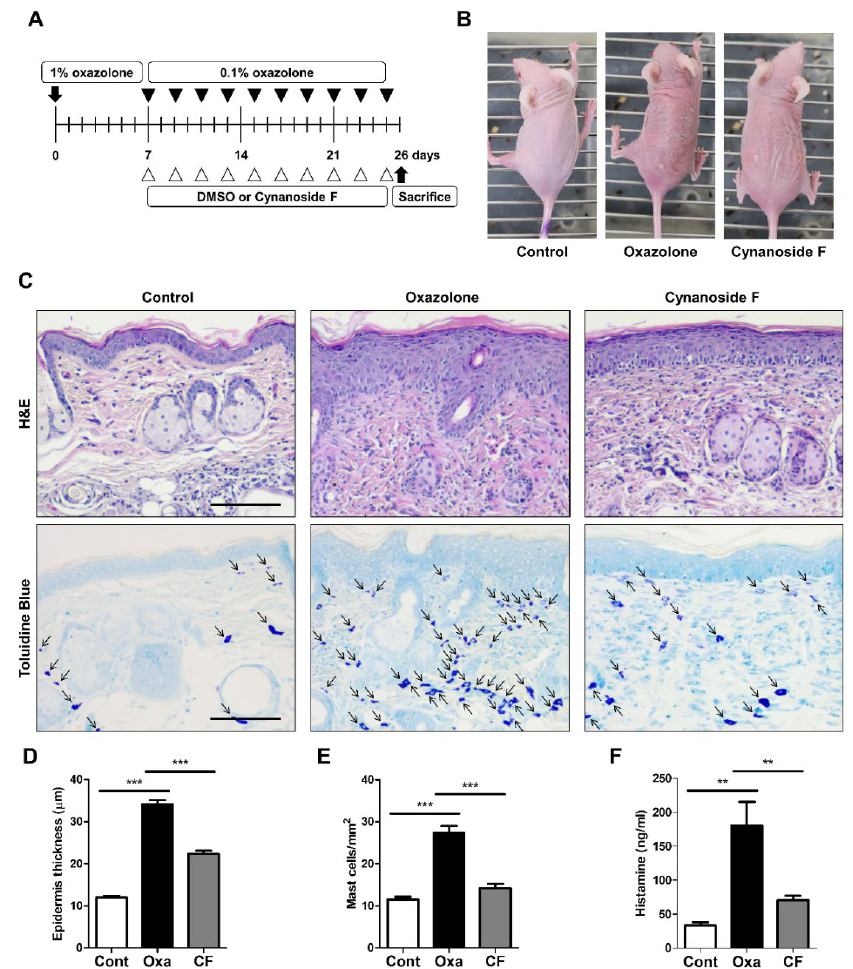
Figure 4. CF inhibits skin inflammation in AD model mice. ( A ) Schematic representation of the experiment. Hairless mice ( n = 5 per group) were treated with oxazolone together with either vehicle (DMSO) or CF (10 µ g/mL). Mice treated with a mixture of acetone and olive oil were used as a control. ( B ) The image shows the dorsal skin of mice on Day 24. ( C ) H&E staining of the epidermis and toluidine blue staining for mast cell infiltration (magnification ×100, scale bar: 50 µm). ( D ) Measurement of the epidermal thickness from five randomized fields. ( E ) Number of mast cells from five randomized fields of each group. ( F ) Histamine levels measured by ELISA. Values are the mean ± SD from five fields in each group ( n = 5). ** p < 0.01; *** p < 0.001.